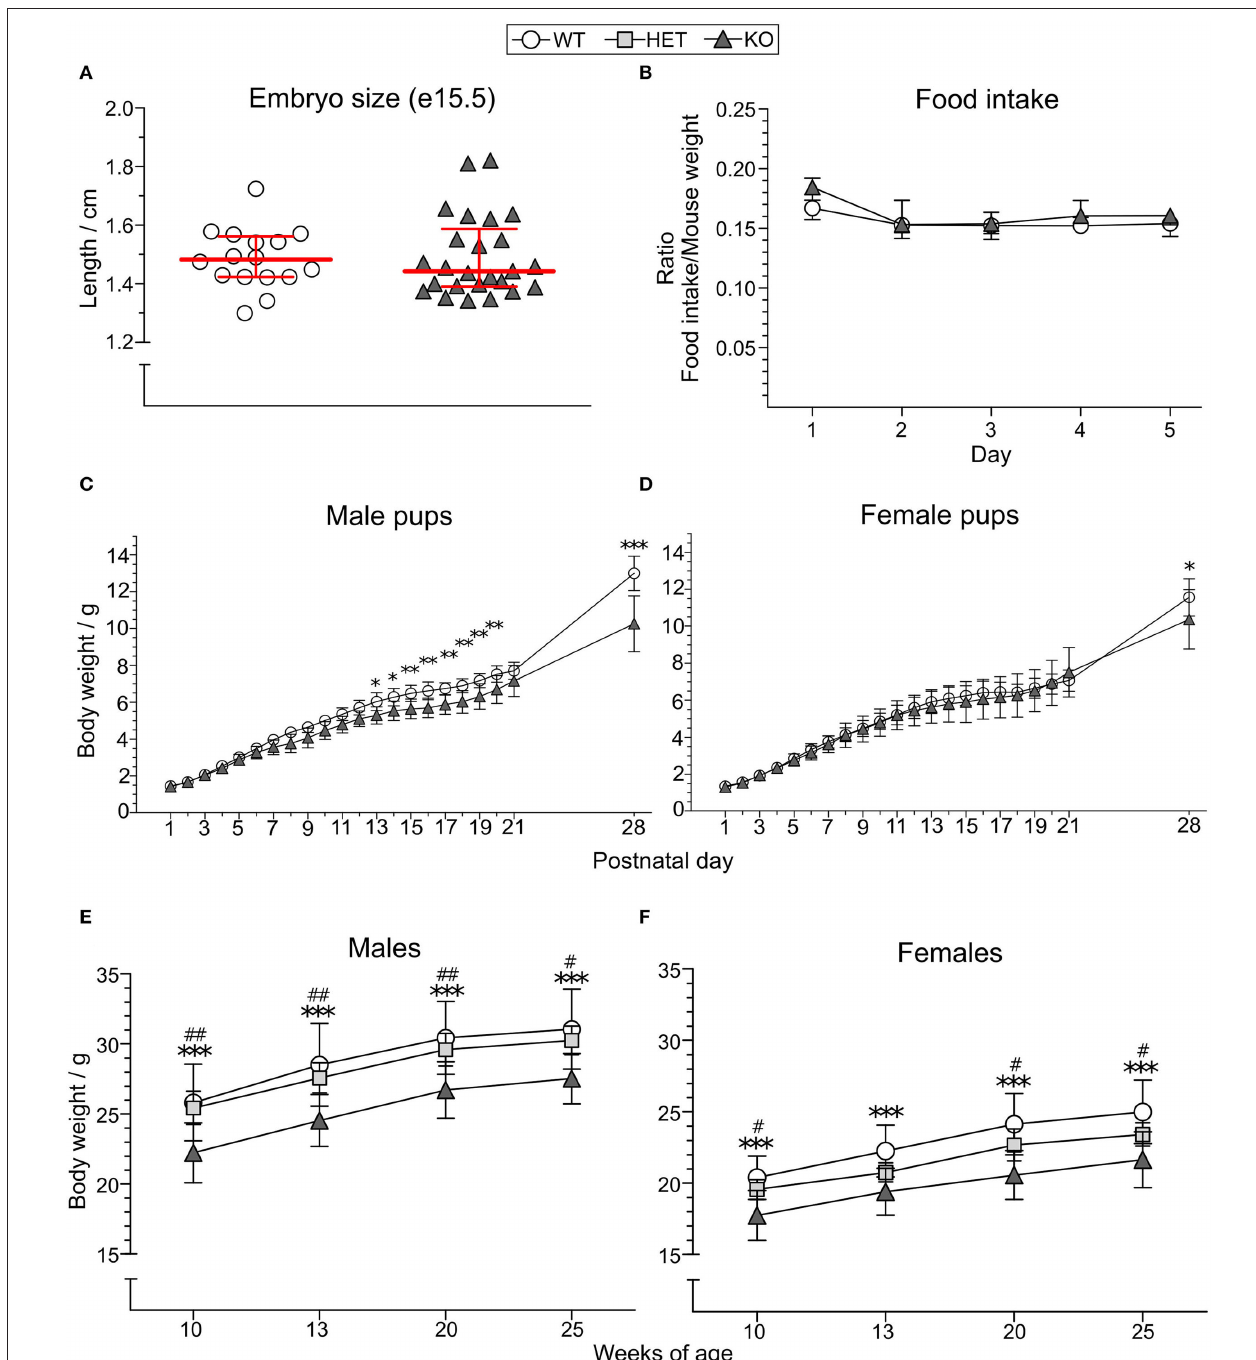
FIGURE 2 | Effect of SLC38A10 knockout on food intake and body weight. (A) Embryos from SLC38A10 − / − mice (KO) ( n = 25) and SLC38A10 + / + mice (WT) ( n = 16) mice at gestational day 15.5 were dissected, photographed, and measured with ImageJ. No significant difference between the groups was observed. (B) Food pellets were weighed every 24h for 5 consecutive days in mice housed two per cage ( n = 9 WT, 7 KO cages) and a ratio of food eaten and mouse weight was calculated. Data in (A,B) are illustrated as medians with interquartile range. (C) Male ( n = 10 WT, 8 KO) and (D) female ( n = 11 WT, 5 KO) pups from KO and WT breedings were weighed (g) from postnatal day 1–28. (E) Male [ n = 12 WT, 10 SLC38A10 + / − mice (HET), 12 KO] and (F) female ( n = 15 WT, 12 HET, 11 KO) adult body weight (g) of KO, HET, and WT mice. Body weight data (C–F) are illustrated as means with standard deviation. Analyses were made with Mann–Whitney U -test for embryo size, food intake with the nparLD package in R, and a two-way ANOVA with Bonferroni post-hoc test for body weight measurements. Statistical differences between KO and WT mice are indicated with an asterisk sign (*), and between KO and HET mice with a hash sign (#), */# p < 0.05, **/## p < 0.01, *** p < 0.001.